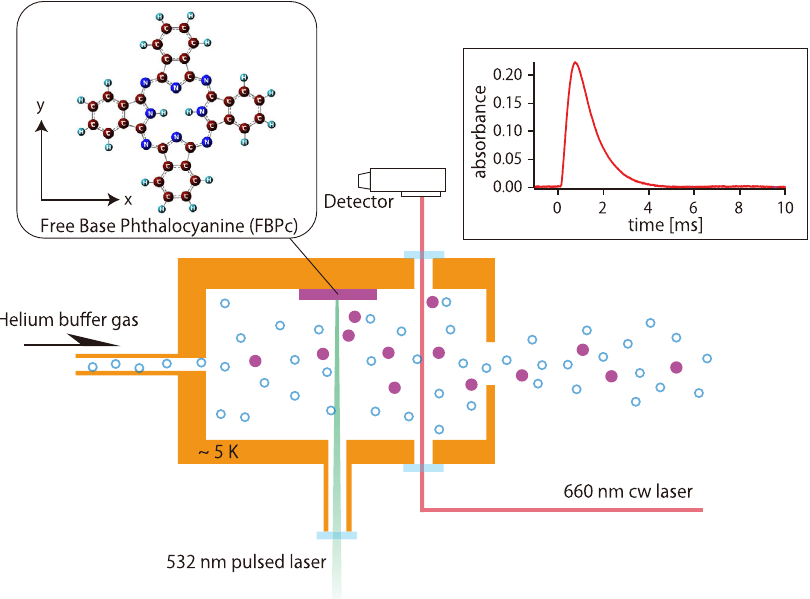
Fig. 1 Schematic of absorption spectroscopy of buffer-gas-cooled free-base phthalocyanine (FBPc). An FBPc tablet fi xed on the wall of a buffer gas cell is laser ablated with nanosecond pulses at 532 nm to obtain gas-phase molecules in the cell. The ablated hot molecules are rapidly cooled by collisions with helium atoms, which are nearly in equilibrium with the cell at 5 K. Helium and FBPc molecules fl ow into the vacuum vessel through an aperture (5 mm diameter). The helium atoms are then adsorbed by charcoal cooled to approximately 5 K to maintain vacuum. A narrow-linewidth continuous-wave laser at 660 nm passes through the cell via an optical port and is measured by a photodetector. The observed absorption increases rapidly after ablation ( t = 0) and reaches the maximum value 1 ms after ablation. Thereafter, the absorption gradually decays over a period of several milliseconds. Absorption spectra were obtained by recording the absorbance at t ∼ 1